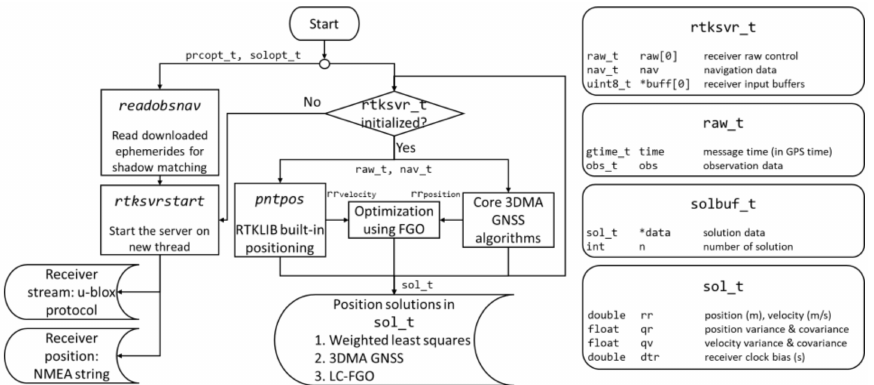
Figure A2. Program flow of this study. The left part is the program structure. The right part is the data dictionary of the primary data structure and members used for